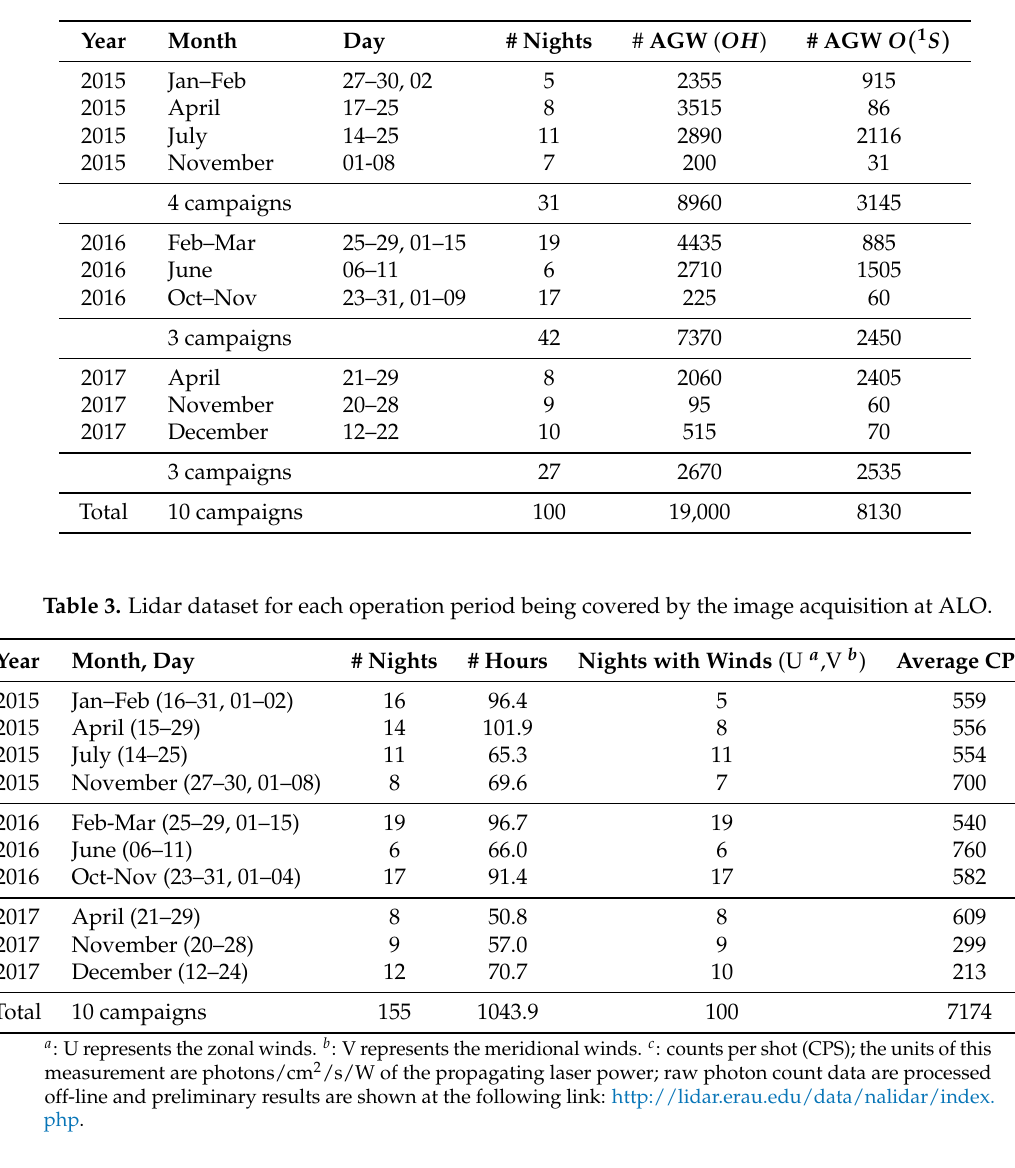
Table 2. Imaging dataset and the number of prominent atmospheric gravity waves (AGWs) detected from the observing campaigns corresponding to 2015, 2016, and 2017 for the OH and O ( 1 S ) emission lines.